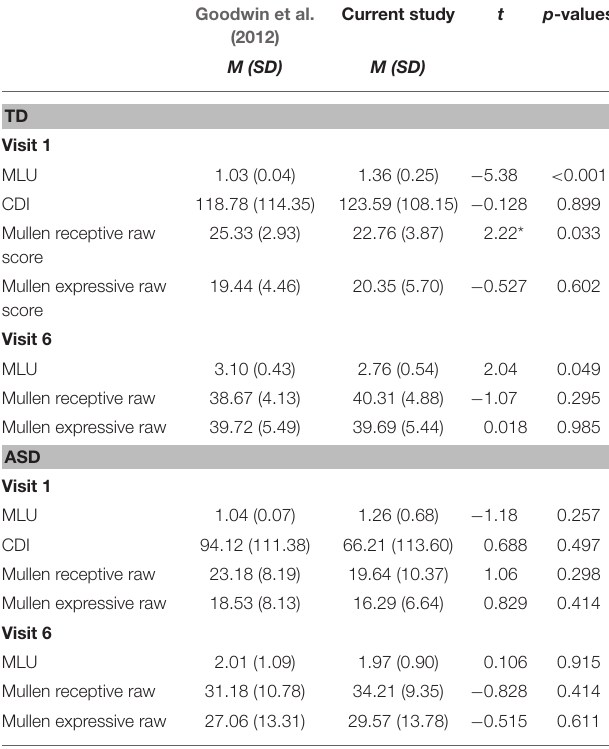
TABLE 6 | Comparison of TD and ASD participants from both cohorts at visits 1 and 6 on the MSEL and CDI.